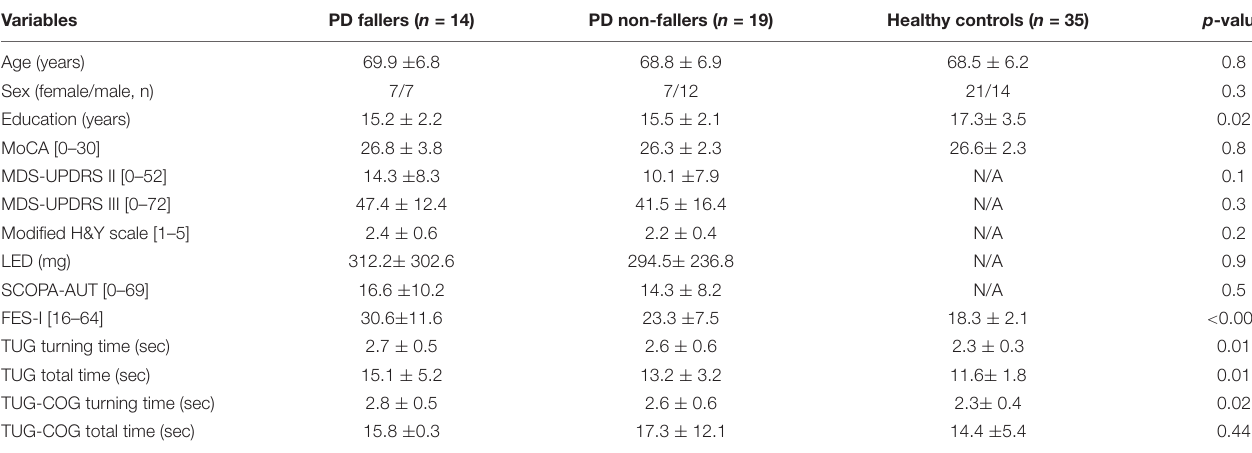
TABLE 1 | Demographic and clinical